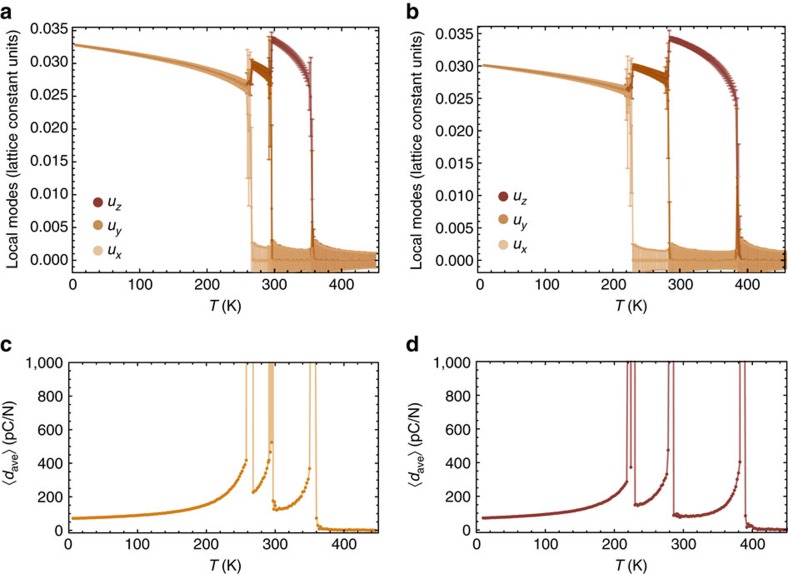
Temperature dependence of macroscopic properties.(a,b) Report the evolution with temperature T of the supercell average of the local modes (in lattice constant units) of (1−x)Ba(Zr0.2Ti0.8)O3−x(Ba0.7Ca0.3)TiO3 with x=0.50 (BCTZ-0.5) and BaTiO3 (BTO), respectively. Error bars indicate s.d., and are less than or equal to the size of the points when not visible. (c,d) Show the evolution with temperature T of the average 〈dave〉 piezoelectric coefficient (see text) for BCTZ-0.5 and BTO, respectively. Note that 〈dave〉 reaches values larger than 1,000 at the Pmm−P4mm, P4mm−Amm2 and Amm2−R3m transitions. Such values are not shown here because they will make it challenging to see piezoelectricity of the order of hundreds of pC/N in c,d. Results in all panels are obtained from the use of 18 × 18 × 18 supercells.